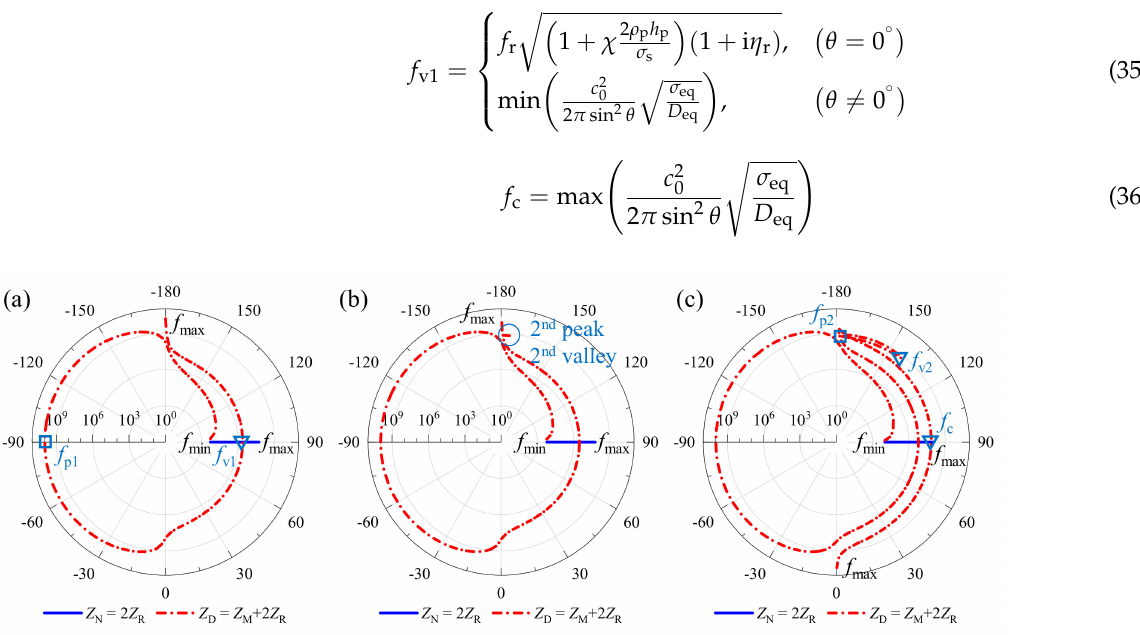
Figure 6. Impedance properties of the metamaterial vary with elevation angle: ( a ) θ = 0 ◦ ; ( b ) θ = 45 ◦ ; and ( c ) θ = 60 ◦